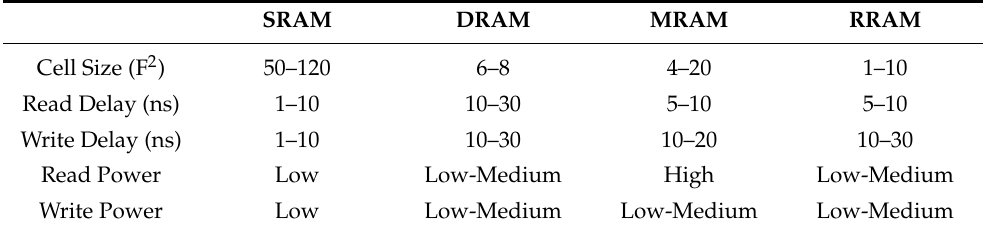
Table 1. Performance comparison of RAMs